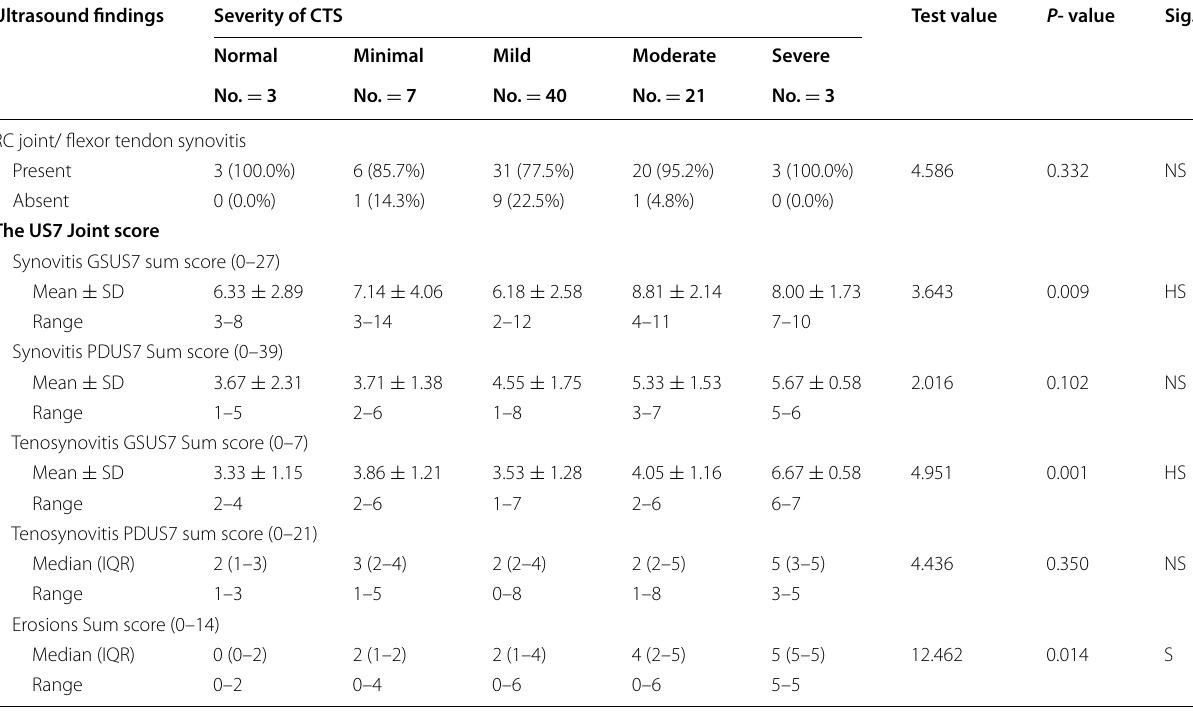
P value 0.05: S Significant